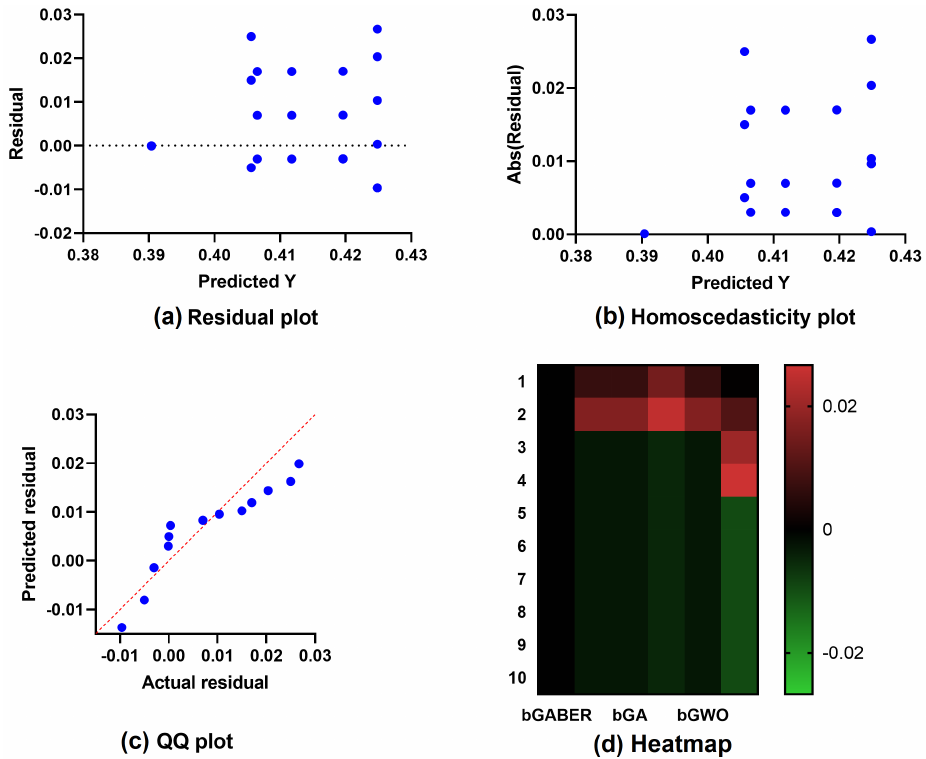
Figure 12. Visualizing the performance of the proposed feature selection method when applied to solar radiation